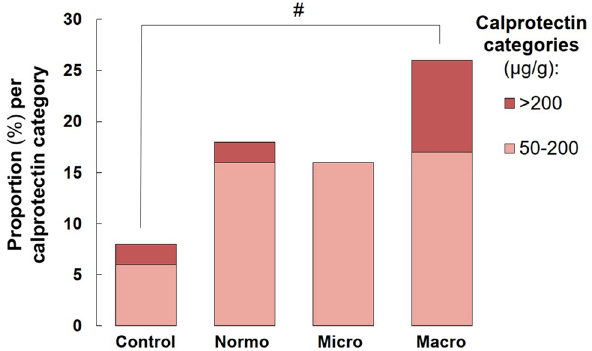
Figure 1. Faecal calprotectin measurements. The proportion of calprotectin positive individuals [expressing either moderate (> 50 μg/g) or high (> 200 μg/g) calprotectin levels] was higher in the macroalbuminuria group compared to controls. Control healthy nondiabetic controls, Normo T1D subjects with normal albuminuria, Micro T1D subjects with microalbuminuria, Macro T1D subjects with macroalbuminuria. # p <